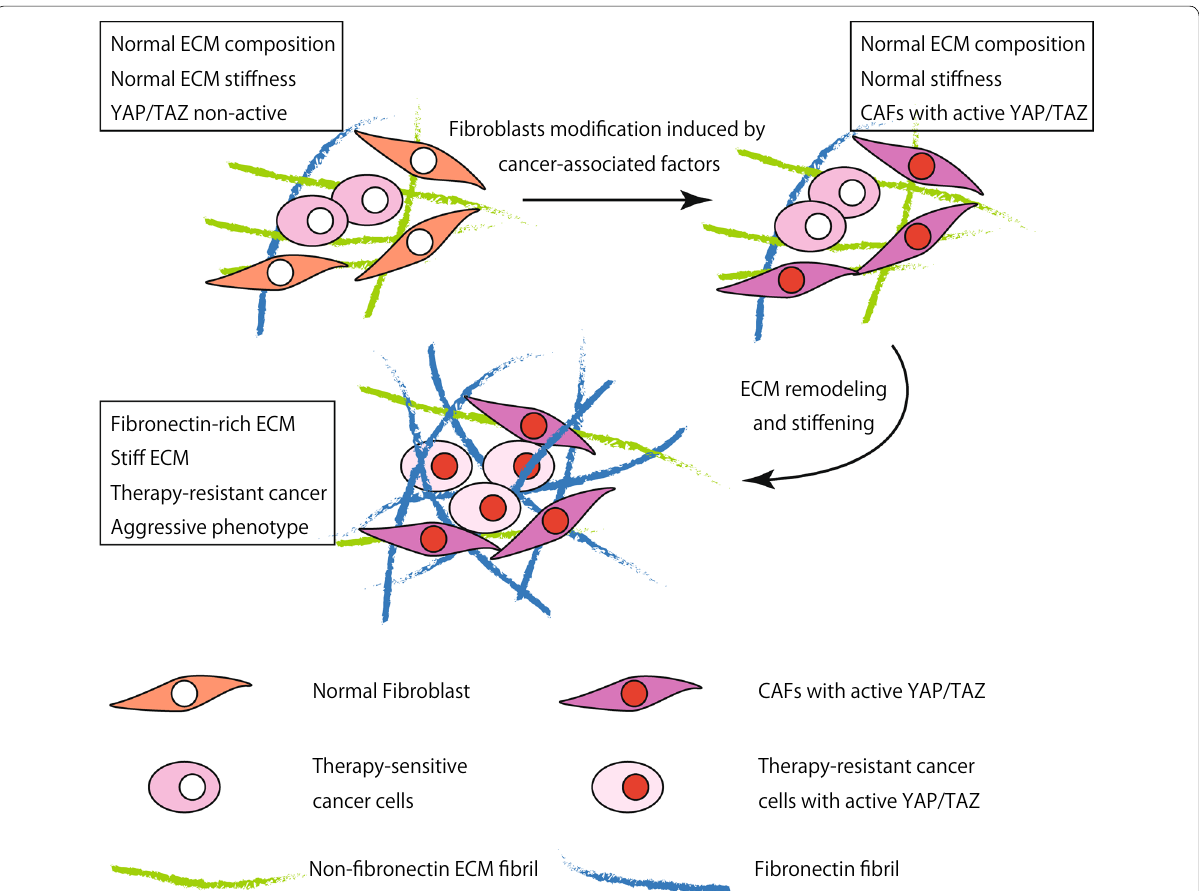
Fig. 6 A hypothetical model of CAF-mediated YAP activation in cancer cells via ECM remodeling. On the first step soluble factors secreted by cancer cells activate YAP in CAFs, leading to ECM remodeling and stiffening. Stiff and fibronectin-rich ECM would promote YAP activation in both CAFs and cancer cells, which confers therapy resistance of